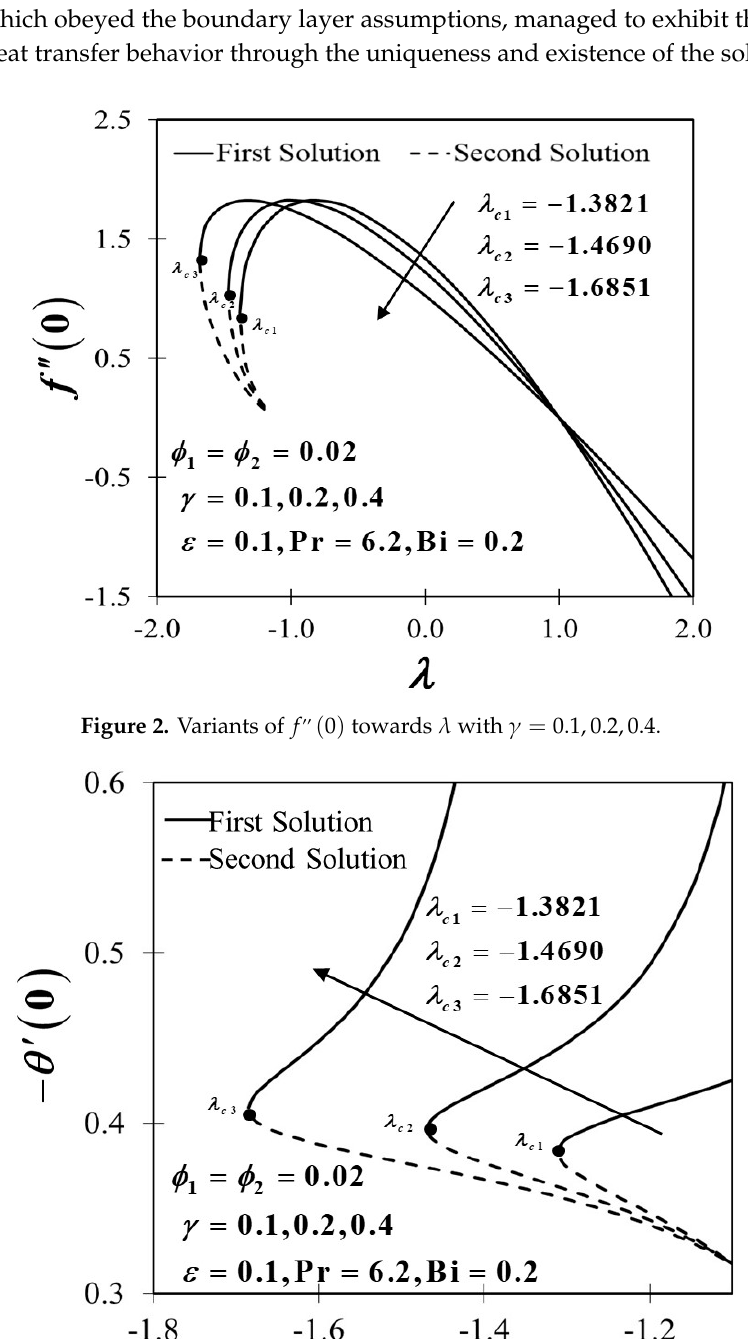
Figure 4. Velocity profiles of